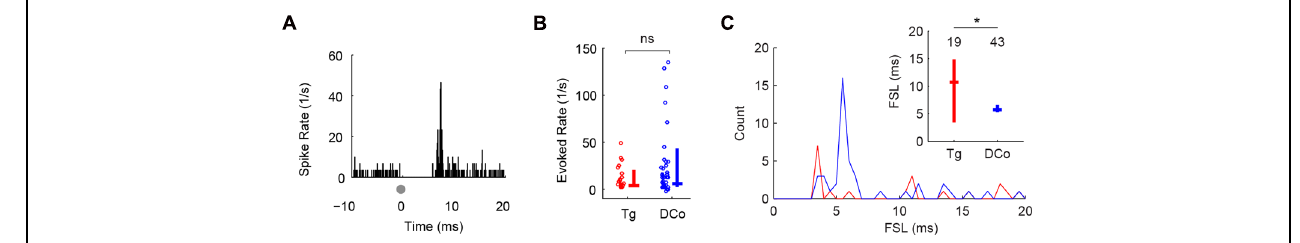
FIGURE 2 | Transcutaneous somatosensory stimulation activates separate pathways to DCN. (A) Representative temporal responses of fusiform cells to transcutaneous electrical stimulation (gray dots at time 0). The absence of spikes before the onset is due to artifact removal during spike sorting. Onset latencies, rates and subsequent sustained responses (Sus) were